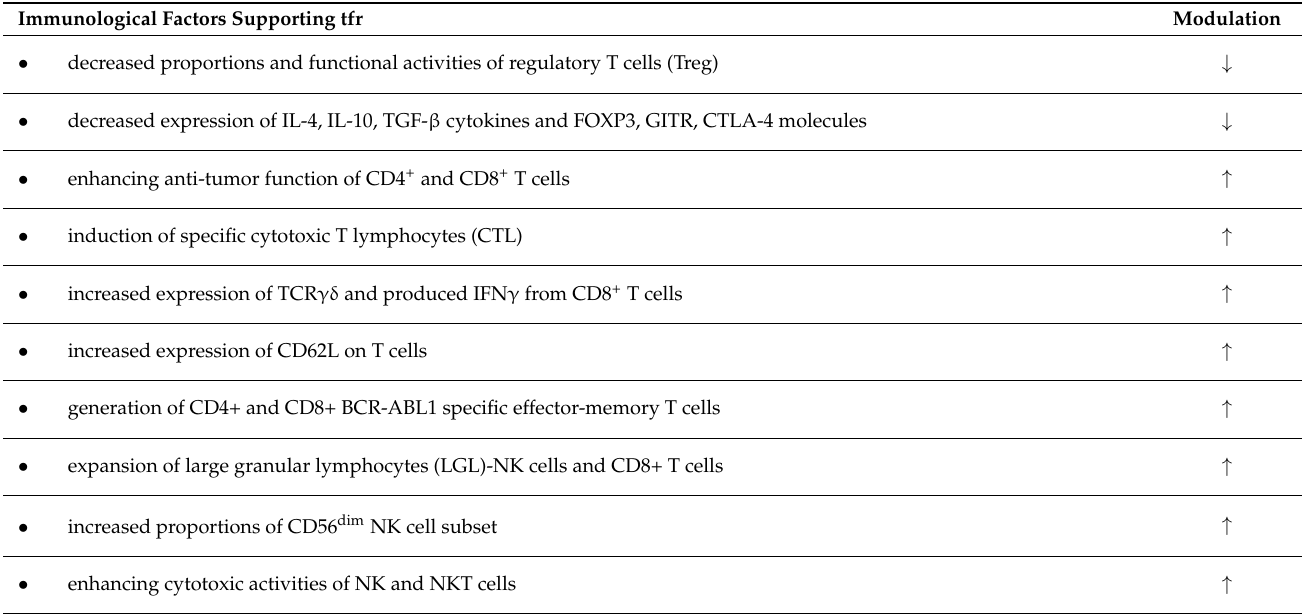
Table 5. Immune system factors critical to the success of